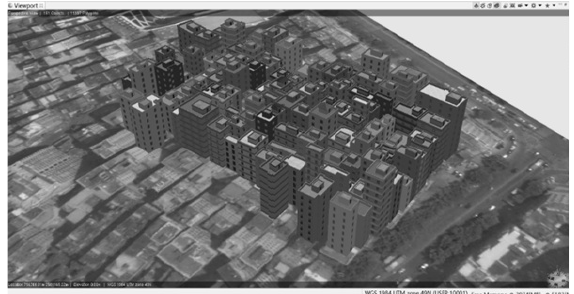
Figure 6. 3D building models of village in the city